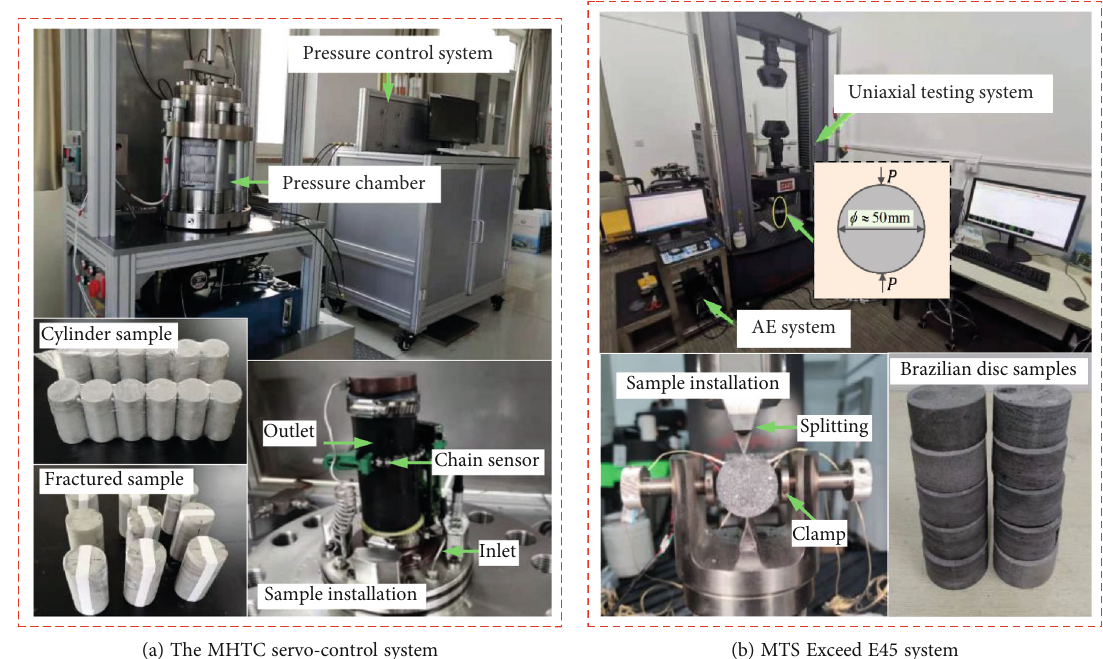
Figure 3: Testing equipment for rock